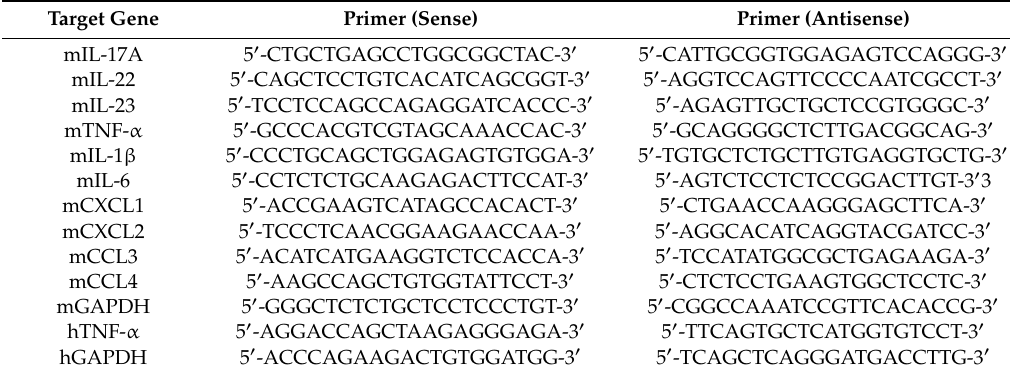
Table 1. Primers used in the real-time